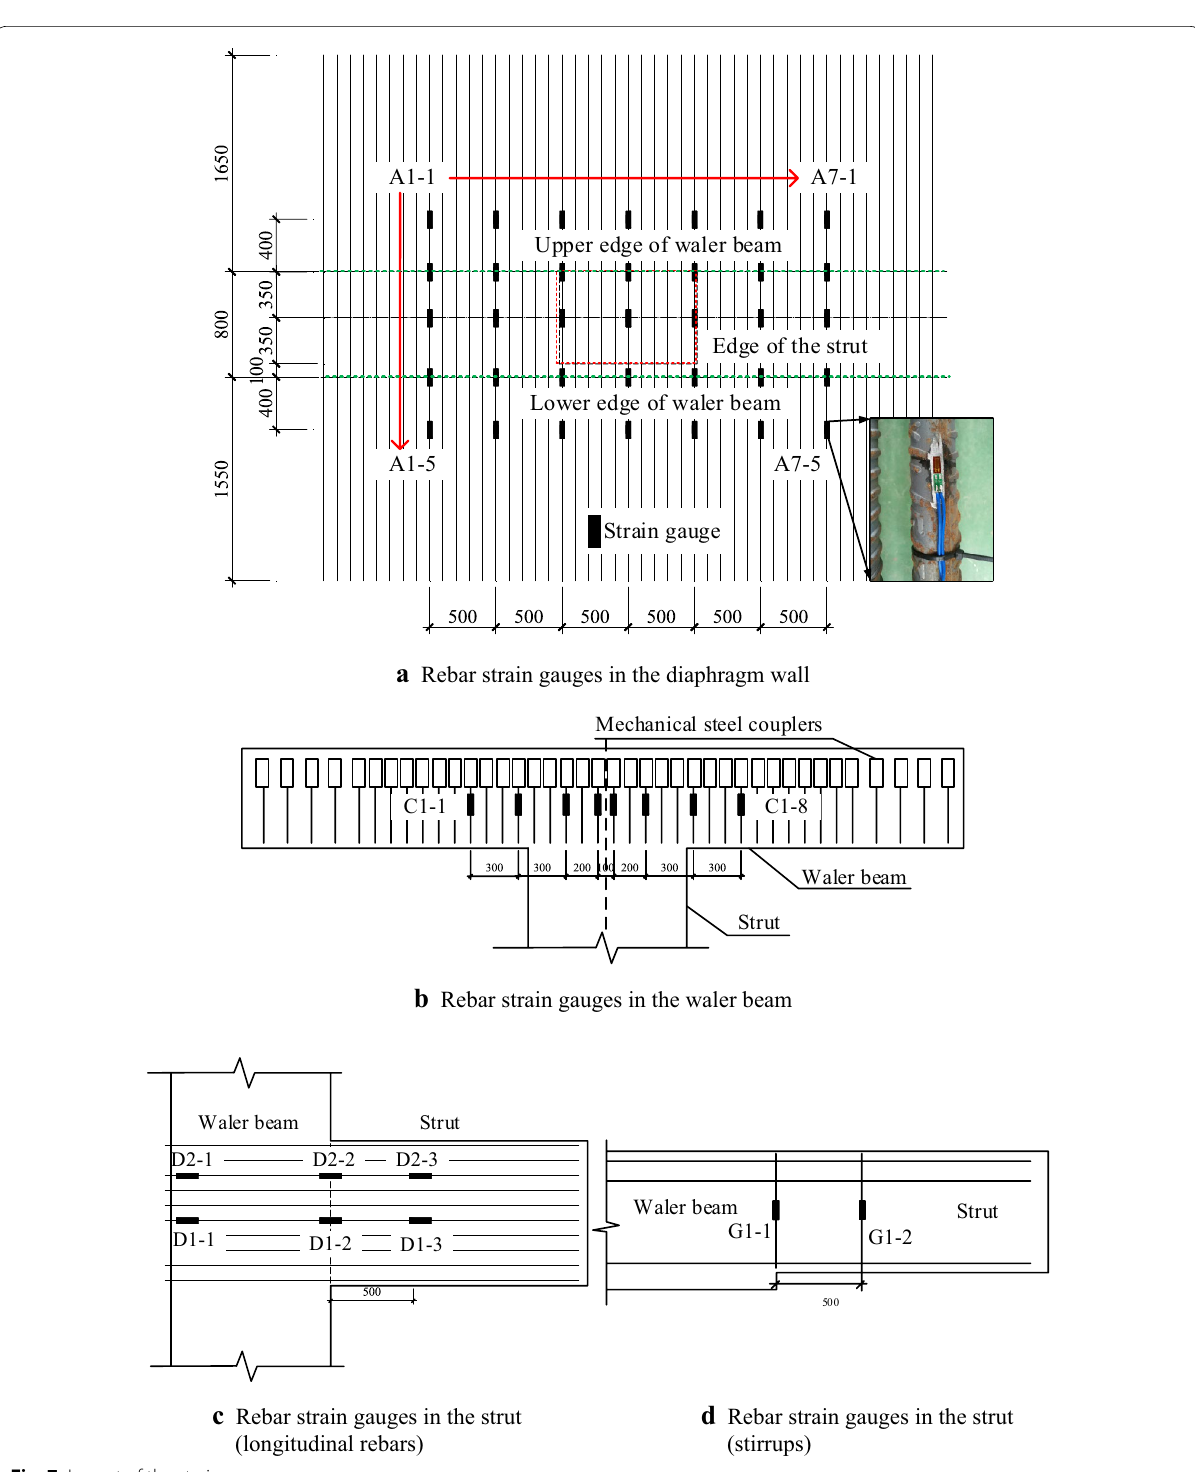
Fig. 7 Layout of the strain